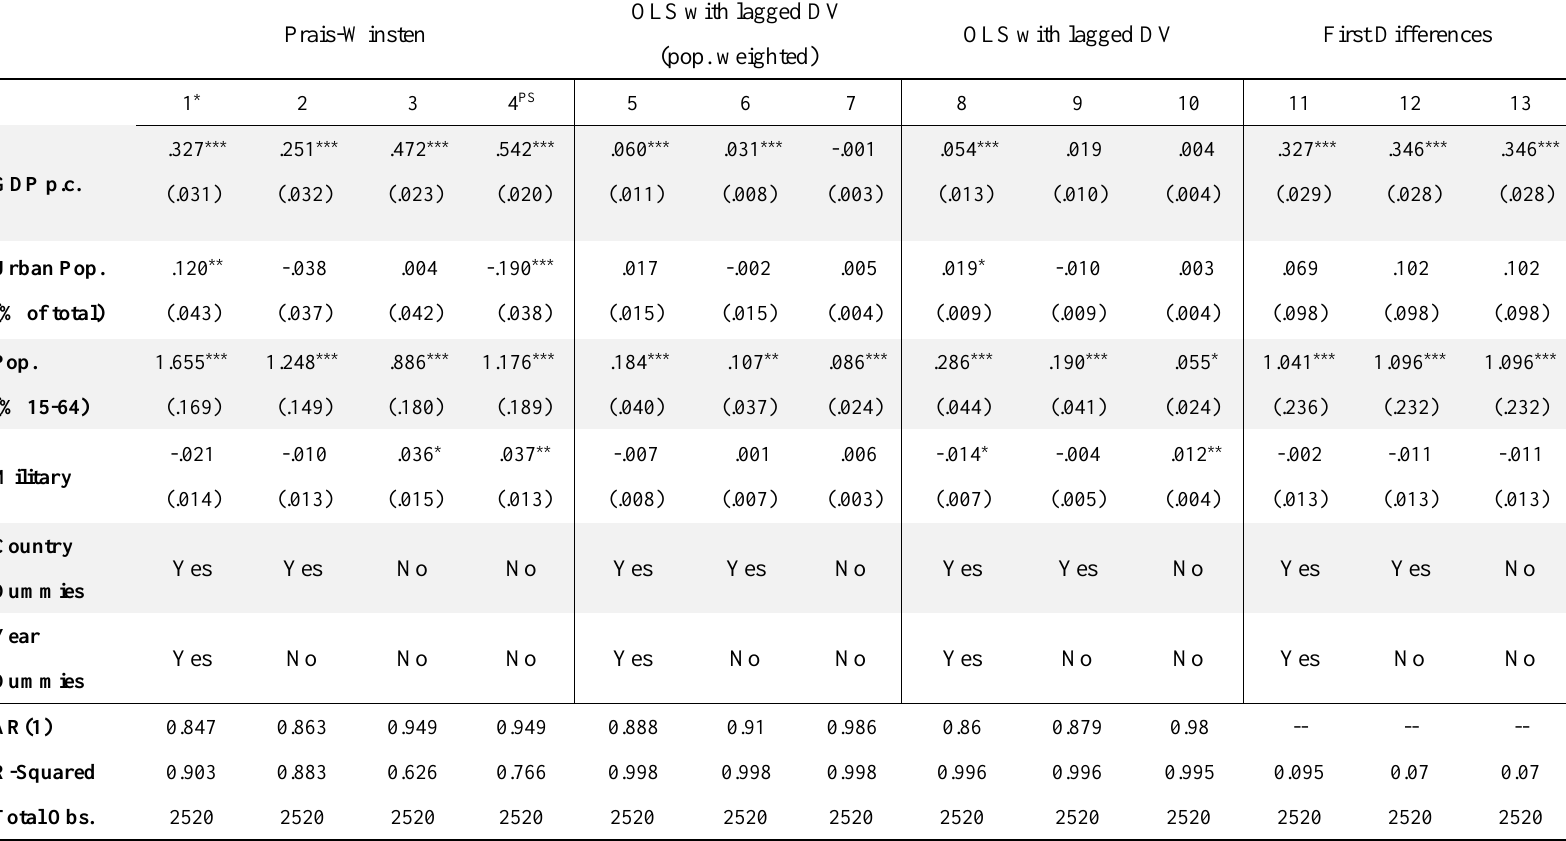
Table 6. Comparison of Different Model Specifications (Balanced Panels – 1975-2014) OLS with lagged DV Prais-Winsten OLS with lagged DV First (pop. weighted)